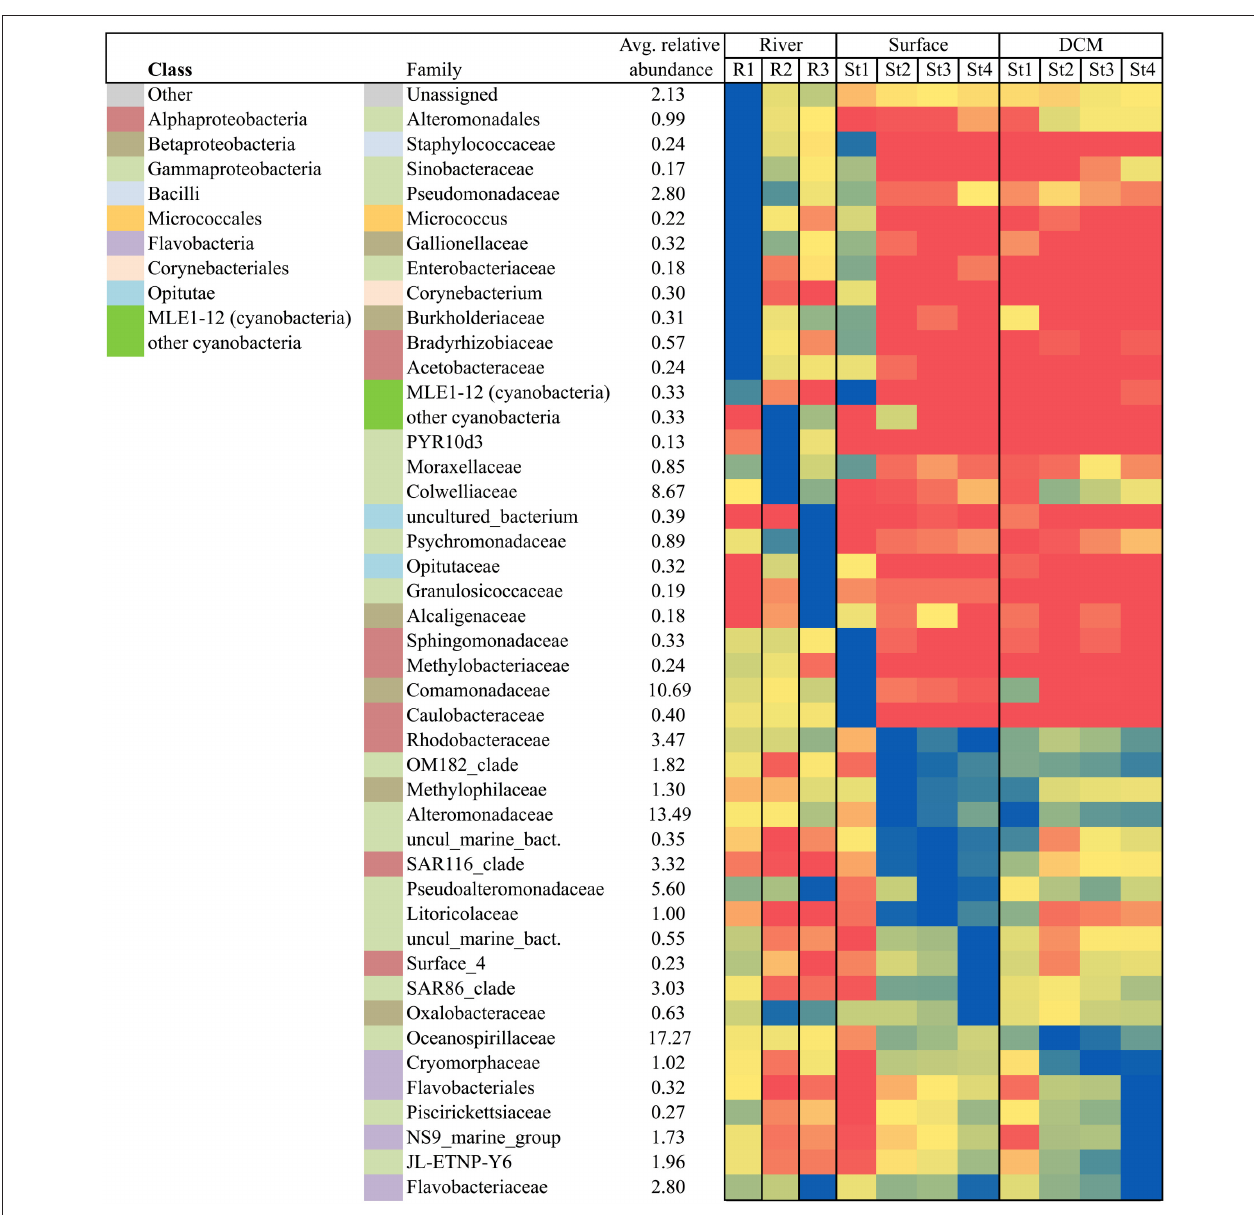
FIGURE 8 | Heat map displaying the highly represented (relative abundance > 1%) bacterial taxa at family level (the class level is indicated from the left hand color-code) across each of the 3 rivers and the 4 fjord stations (1m and DCM) all sampled from August 1 to 10. The highest abundance of each of the 45 bacterial families (including cyanobacteria) was used as respective maximum and the remaining samples are given as a percentage relative to the maximum. The darkest blue illustrates maximum, yellow medium, and red lowest